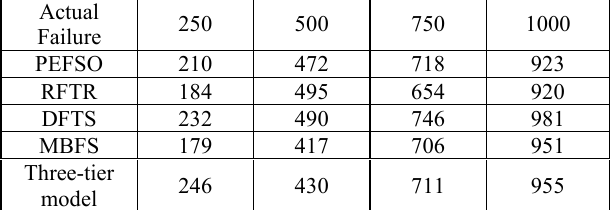
Table .4. Comparison of rejection ratio (%) Table. 5. Comparison of Failure Task